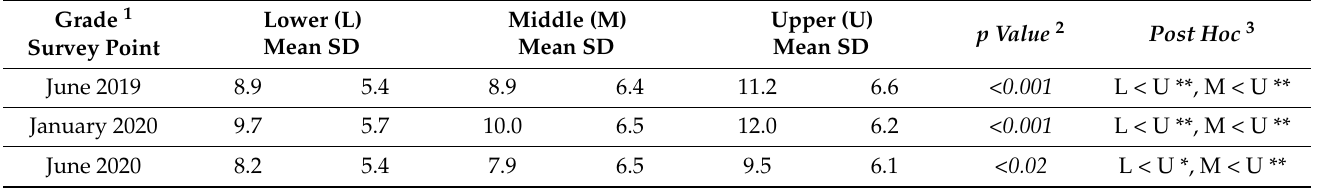
Table 2. Cross-sectional comparison of PDSS scores between